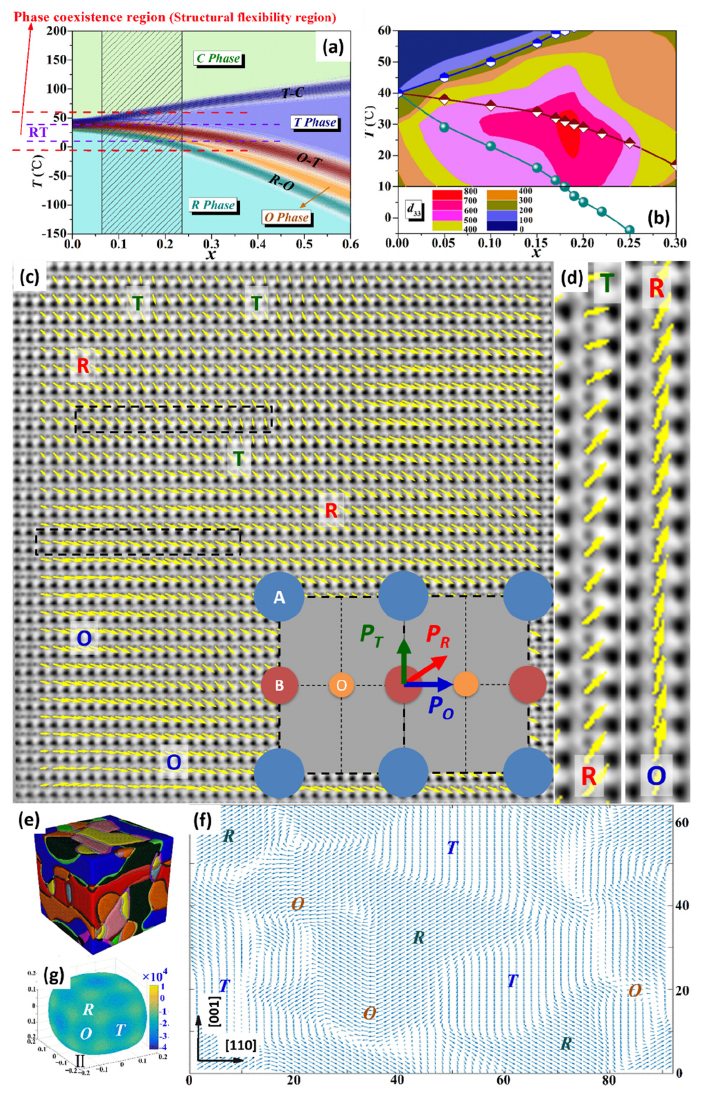
Figure 3. Practical high piezoelectricity in BaTiO 3 -based piezoelectric material using a quadruple critical point. ( a ) Schematic showing phase coexistence regimes based on phase diagram of (1 − x )Ba(Ti 0.89 Sn 0.11 )O 3 − x (Ba 0.7 Ca 0.3 )TiO 3 (BTS-BCT). Three dark stripes represent the R - O , O - T , and T - C polycrystalline phase transition regions, respectively. The region between red lines represents the phase coexistence region formed by the overlap of three bands. The shaded area shows the corresponding composition of the phase coexistence region of the high piezoelectric coefficient d 33 at indoor temperature. ( b ) Contour map of d 33 coefficient in the temperature-composition plane for BTS- x BCT. Atomic-resolution polarization mapping for phase coexistence and gradual polarization rotation. ( c ) The δ Ti-O displacement vector maps based on atomically-resolved STEM ABF image, the displacement vectors are indicated as arrows, the T , O and R regions are marked, and the inset is schematic projection of ABO 3 unit cell along the {110} region axis, polarization directions for the T , O and R phases are marked accordingly. ( d ) Enlarged image showing continuous polarization rotation from R to T and from O to R . Theoretical calculation of BaTiO 3 with multiphase coexistence and simulation for phase coexistence and continuous polarization rotation. ( e ) Phase-field simulations of three phase coexistence. ( f ) The projection for polarizations of ( e ) on the {110} plane. ( g ) Free-energy profiles of QCP. Reproduced from ref